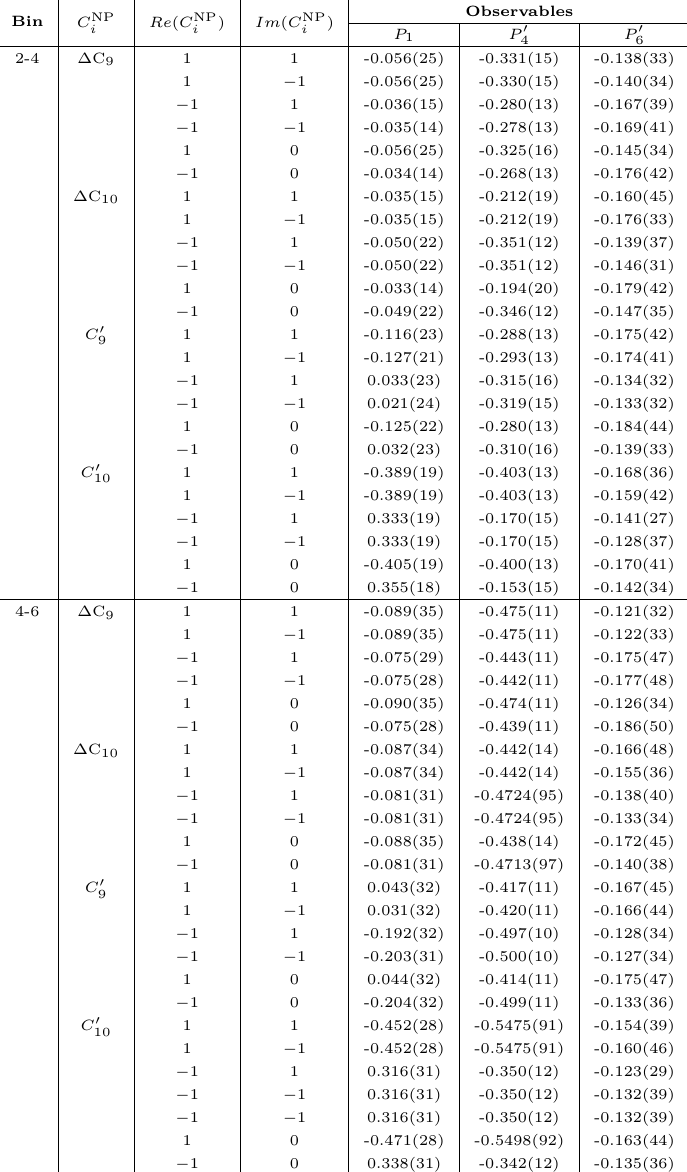
Table 37 . The dependence of the optimized observables corresponding to and imaginary parts of the NP WC’s ∆ C few benchmark values of the real and imaginary parts of the corresponding